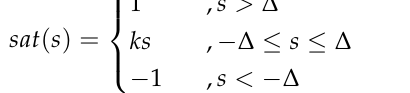
Table 4. Simulation parameters.